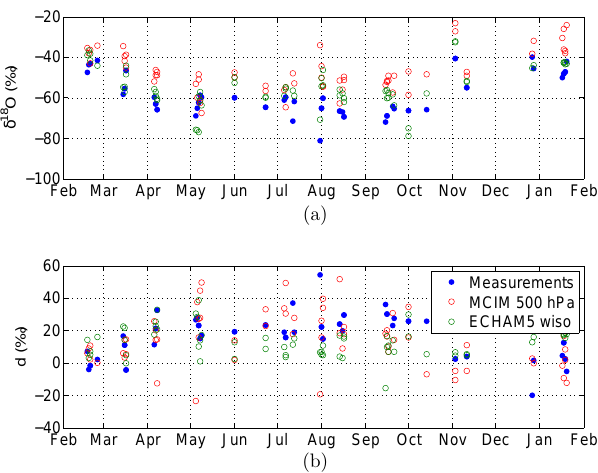
Figure 13. Isotopic composition of precipitation for the days with a measured or modelled precipitation event (excluding days where no trajectories were available) used from measurements, MCIM (with arrival level at 500hPa) and ECHAM5-wiso: (a) δ 18 O and (b) deu- terium